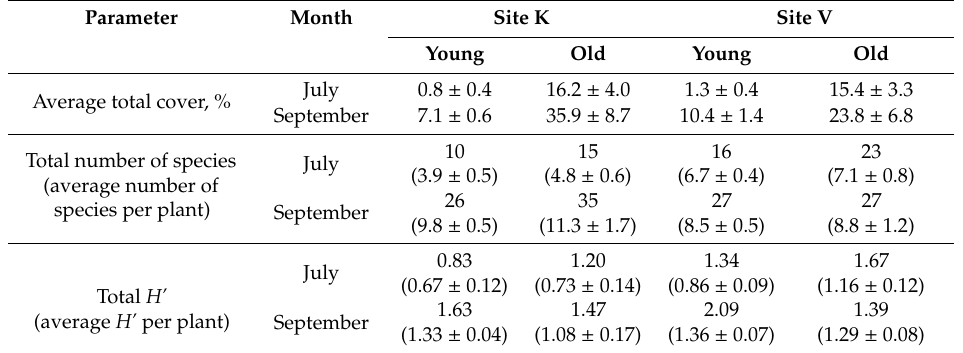
Table 2. Average total cover, number of species and Shannon-Wiener diversity index ( H’ ) of epibiosis on Phycodrys rubens by month, site and plant part age in 2015 (frames